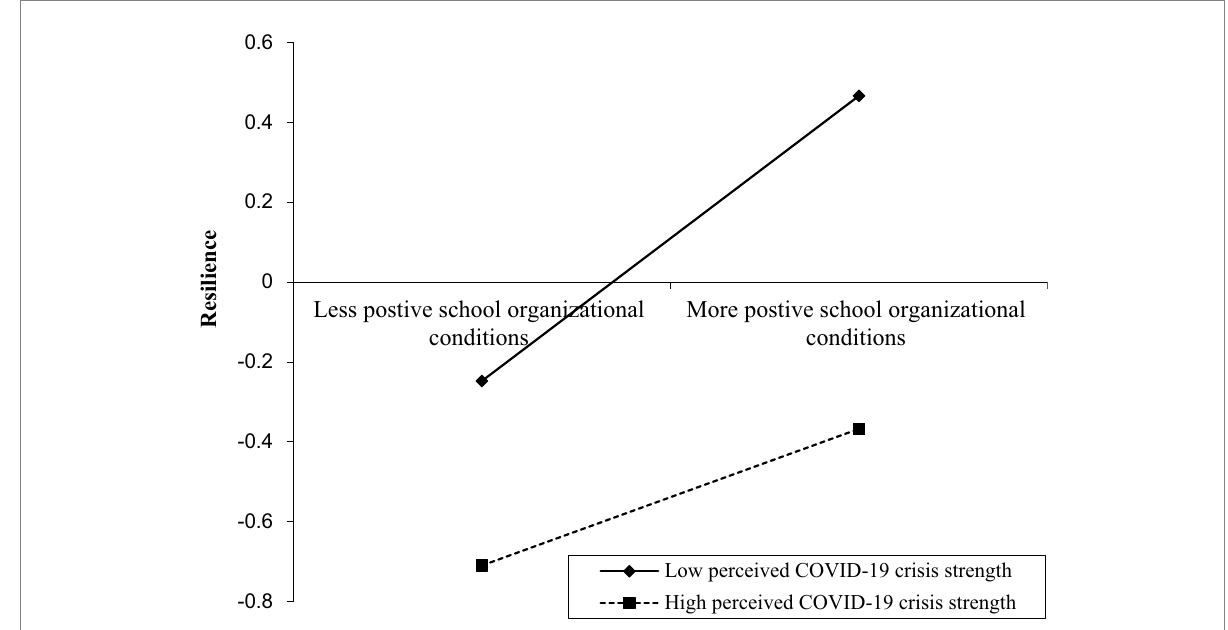
FIGURE 2 Perceived COVID-19 crisis strength moderates the indirect relationship between school organizational conditions and psychological resilience.